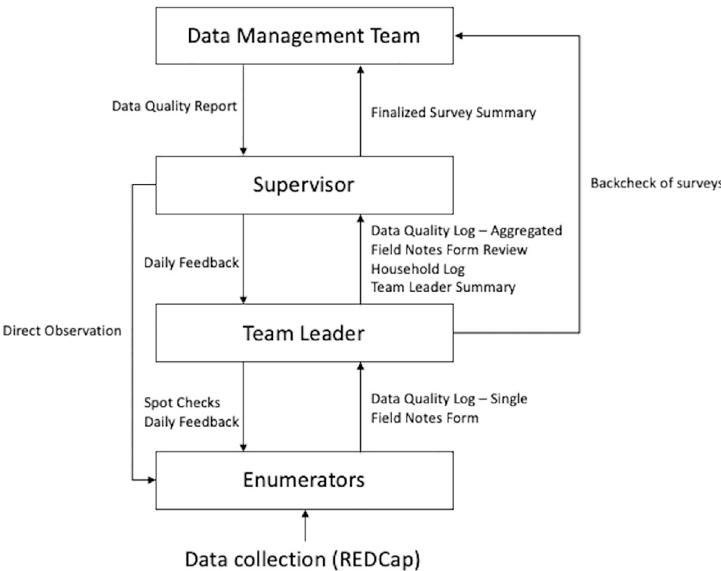
Fig 3. Data quality plan. Daily, bidirectional data quality checks will be conducted to ensure high-quality data collection. Enumerators will log any quality concerns and any issues during the survey day, which are reported to Team Leaders. Team Leaders review these forms and report to the Supervisor. The Supervisor then creates an aggregate summary that is distributed to the Data Management Team at the end of each survey day. The Data Management Team reviews the data present in REDCap each night for both internal validity and accuracy compared to field reports. This then forms the basis of a quality report that is reviewed with Supervisors and Team Leaders prior to the next survey